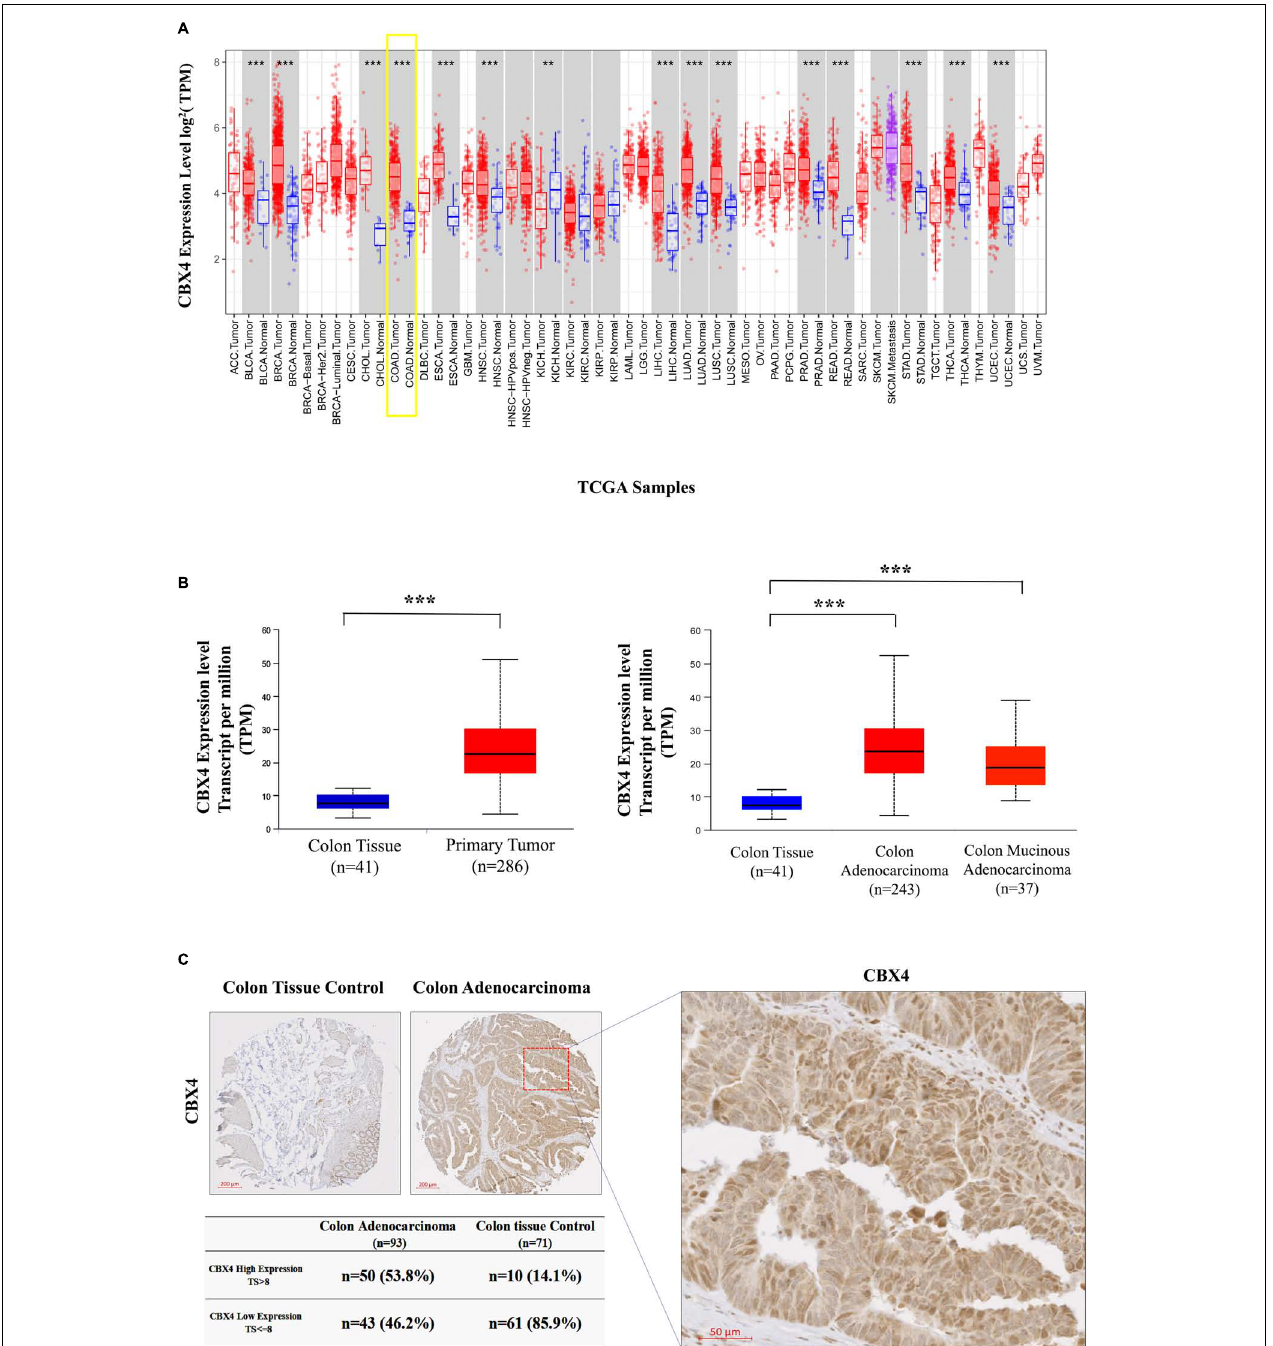
FIGURE 1 | CBX4 is Preferentially Expressed in Human Colon Adenocarcinoma (COAD). (A) Human CBX4 expression levels in different tumor types derived from TCGA were determined by the Diff Exp module of TIMER. Red bars represent tumor tissues and blue bars are adjacent normal tissues. The gray columns here mean “normal control data are available”. The significant up- or down- regulation of CBX4 in the tumors, when compared to normal tissues, was indicated with the symbols (* P < 0 . 05, ** P < 0 . 01, and *** P < 0 . 001). (B) CBX4 expression levels in COAD were analyzed by UALCAN, box plots (left) showing the levels of CBX4 in normal ( n = 41) and colon cancer samples ( n = 286), and box plots (right) showing those of CBX4 in normal ( n = 41), colon adenocarcinoma ( n = 243) and colon mucinous adenocarcinoma ( n = 37). The read counts were normalized in TPM (Transcripts Per Kilobase Million). (C) Immunohistochemitry on a total of 93 cases of primary colon adenocarcinoma. Each patient was represented by one core of adenocarcinoma sample ( n = 93), and the majority contained one core of non-neoplastic colon tissue control ( n = 71). By taking into consideration of a intensity score (i) and a distribution score (Pi), a total score (TS) = Pi* (i + 1) was assigned for each sample using a score of 8 as a cutoff to compare the dichotomized cases with high and low expression of CBX4.